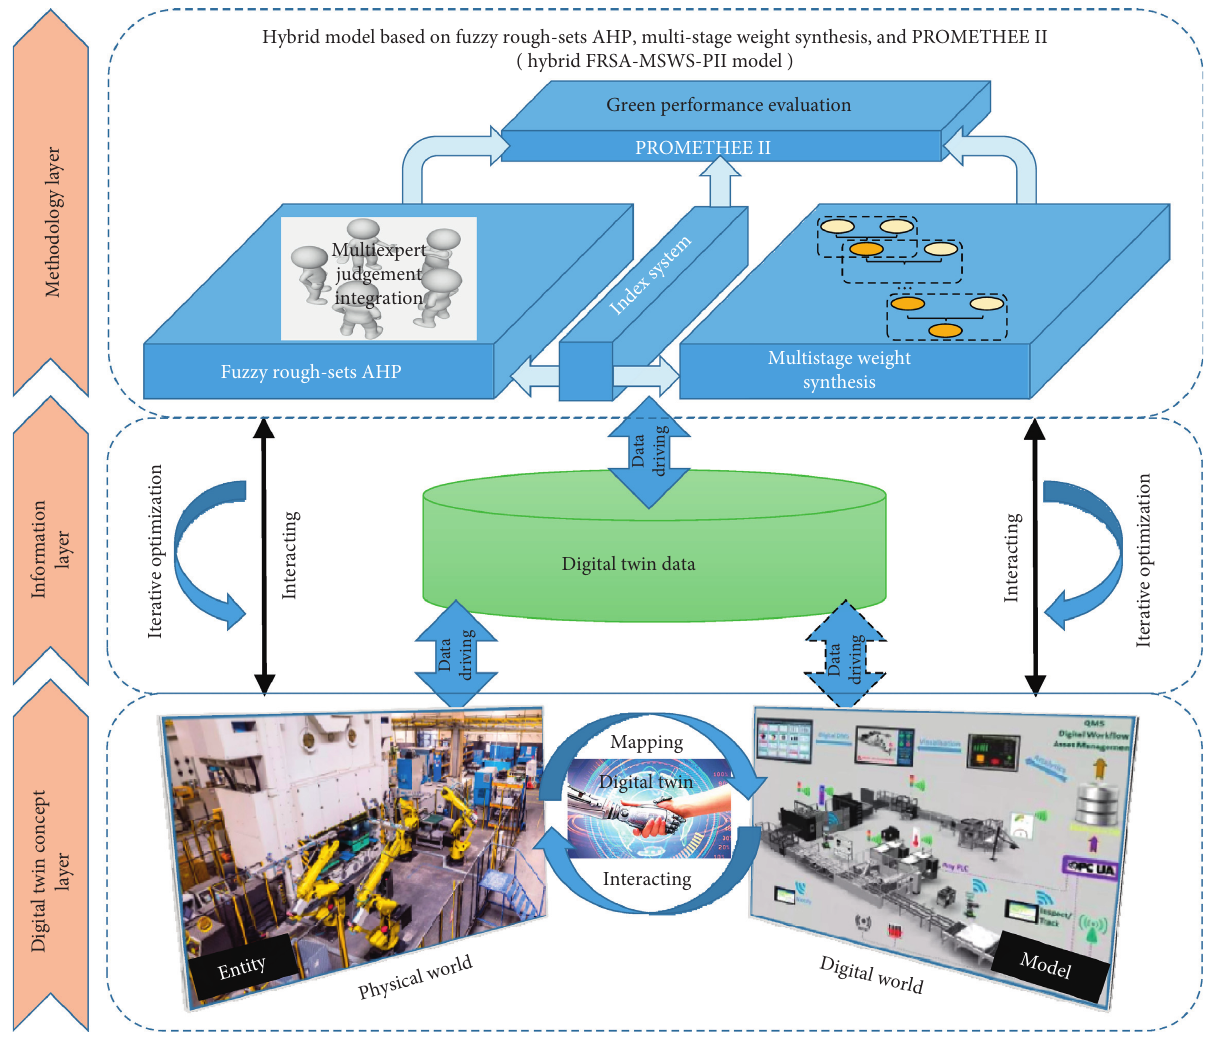
Figure 1: Green performance evaluation framework of intelligent manufacturing driven by digital